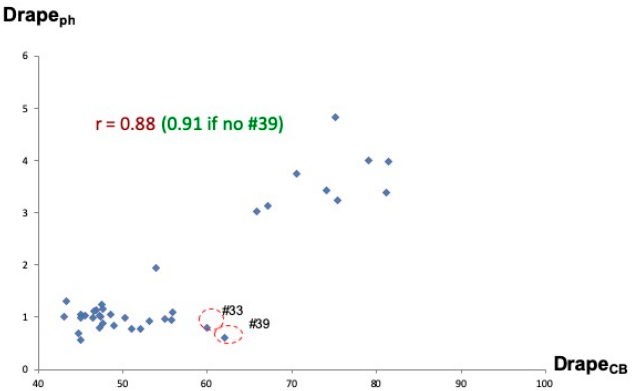
Figure 7. PhabrOmeter Drape and Cotton Cusick data (n = 38) (sata not available for Aamples #9 and #10).